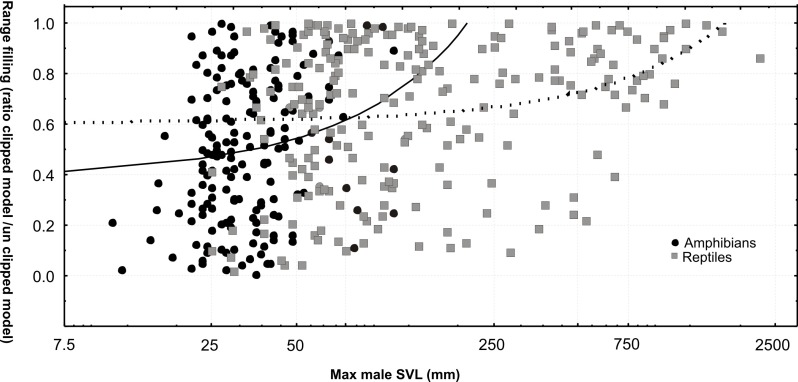
Range filling of reptiles and amphibians.Correlation of range filling (ratio of range sizes of clipped distribution model vs. full distribution model) with SVL, separately for amphibians (black solid circles) and reptiles (squares). Analyses carried out after removing all taxa with 1–2 data points only.